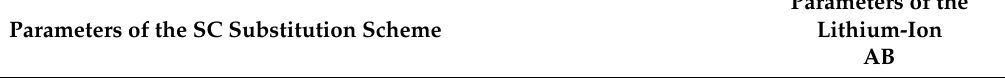
Table 2. Parameters of the SC and lithium-ion battery.